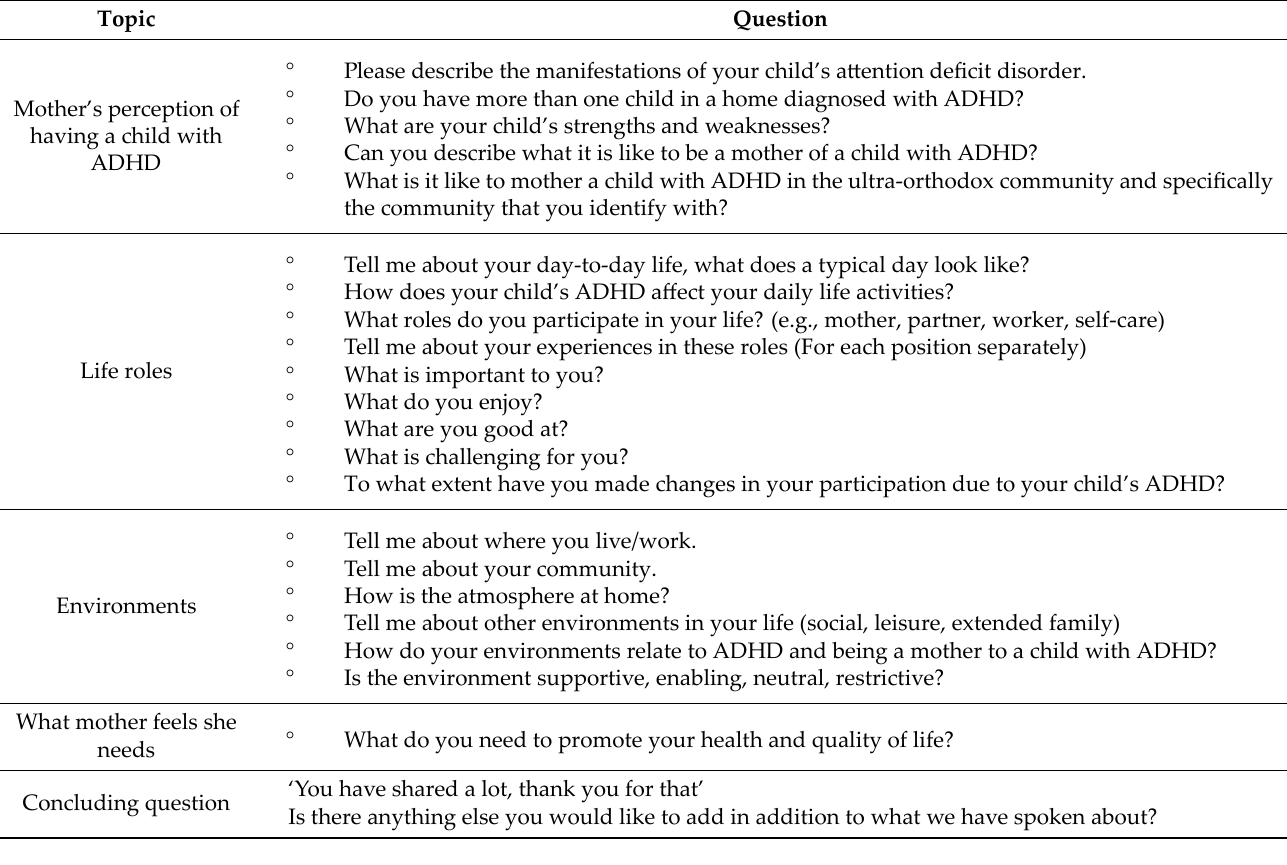
Table 3. Semi‑structured qualitative